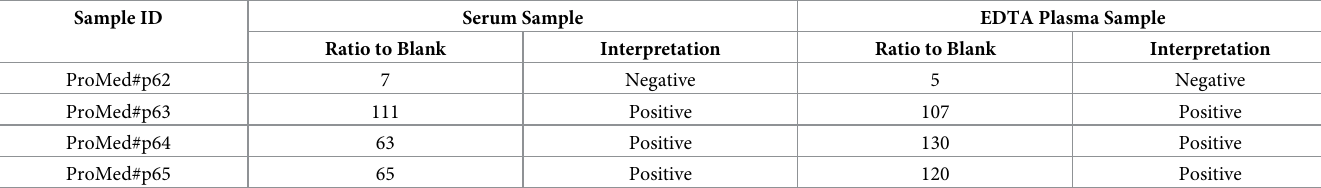
Table 2. Comparison between 4 pairs of matched serum and EDTA plasma samples.